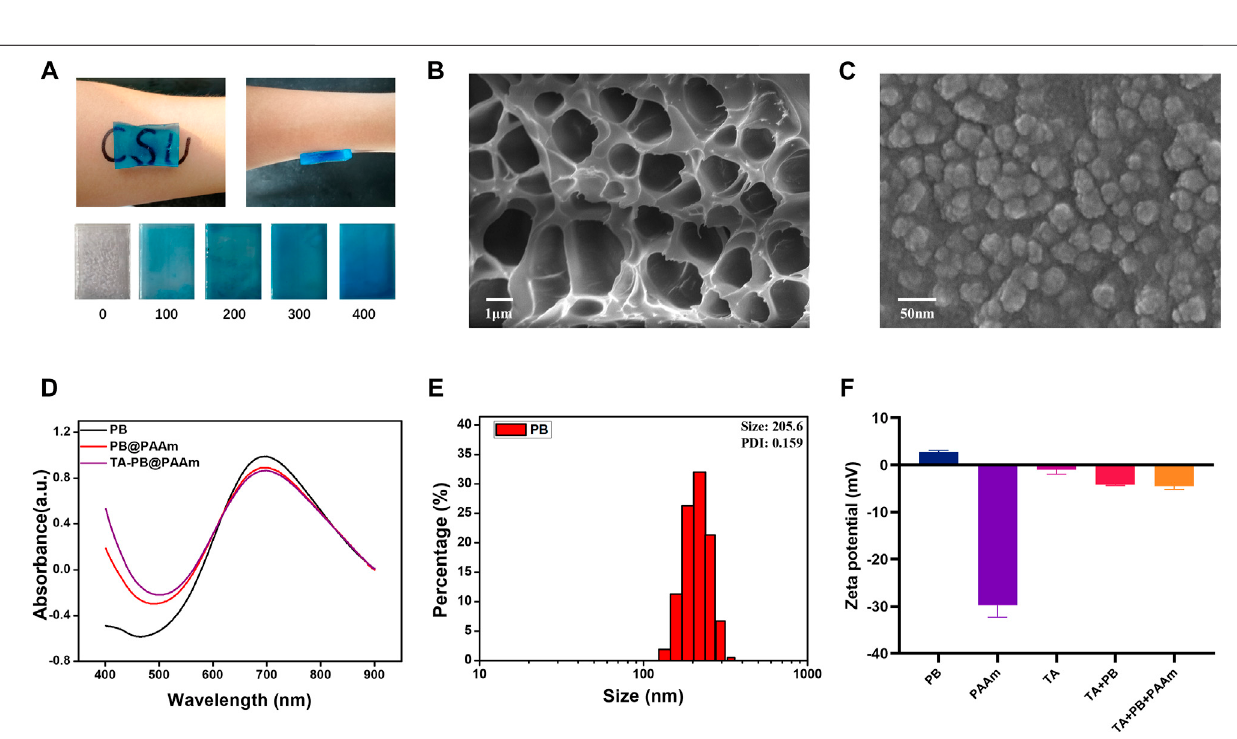
Frontiers in Bioengineering and Biotechnology |